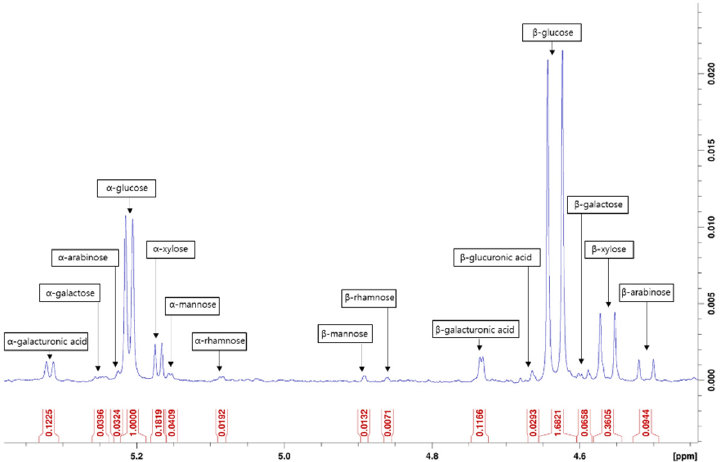
Figure 2. Anomeric hydrogens in the NMR spectrum of monosaccharides in kenaf outer bast.